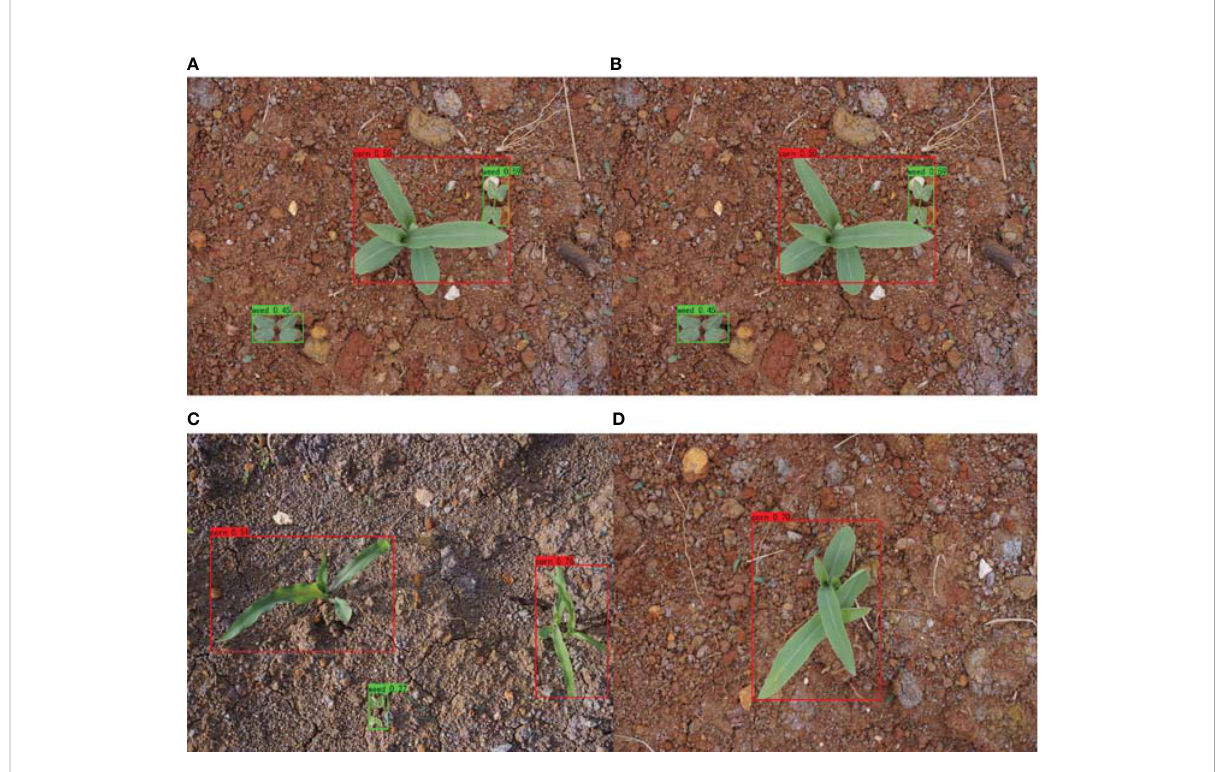
FIGURE 14 Visual system test result